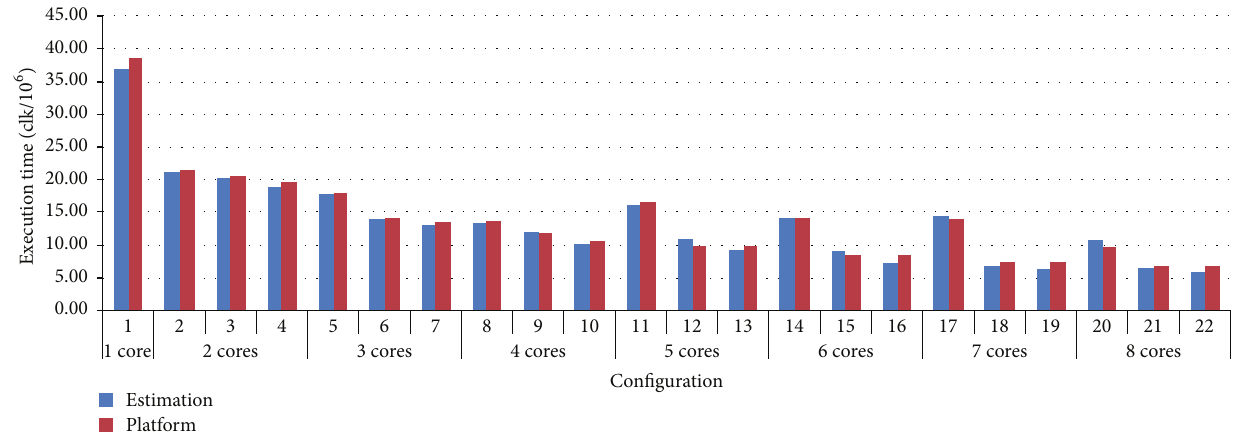
Figure 5: Consistency verification.